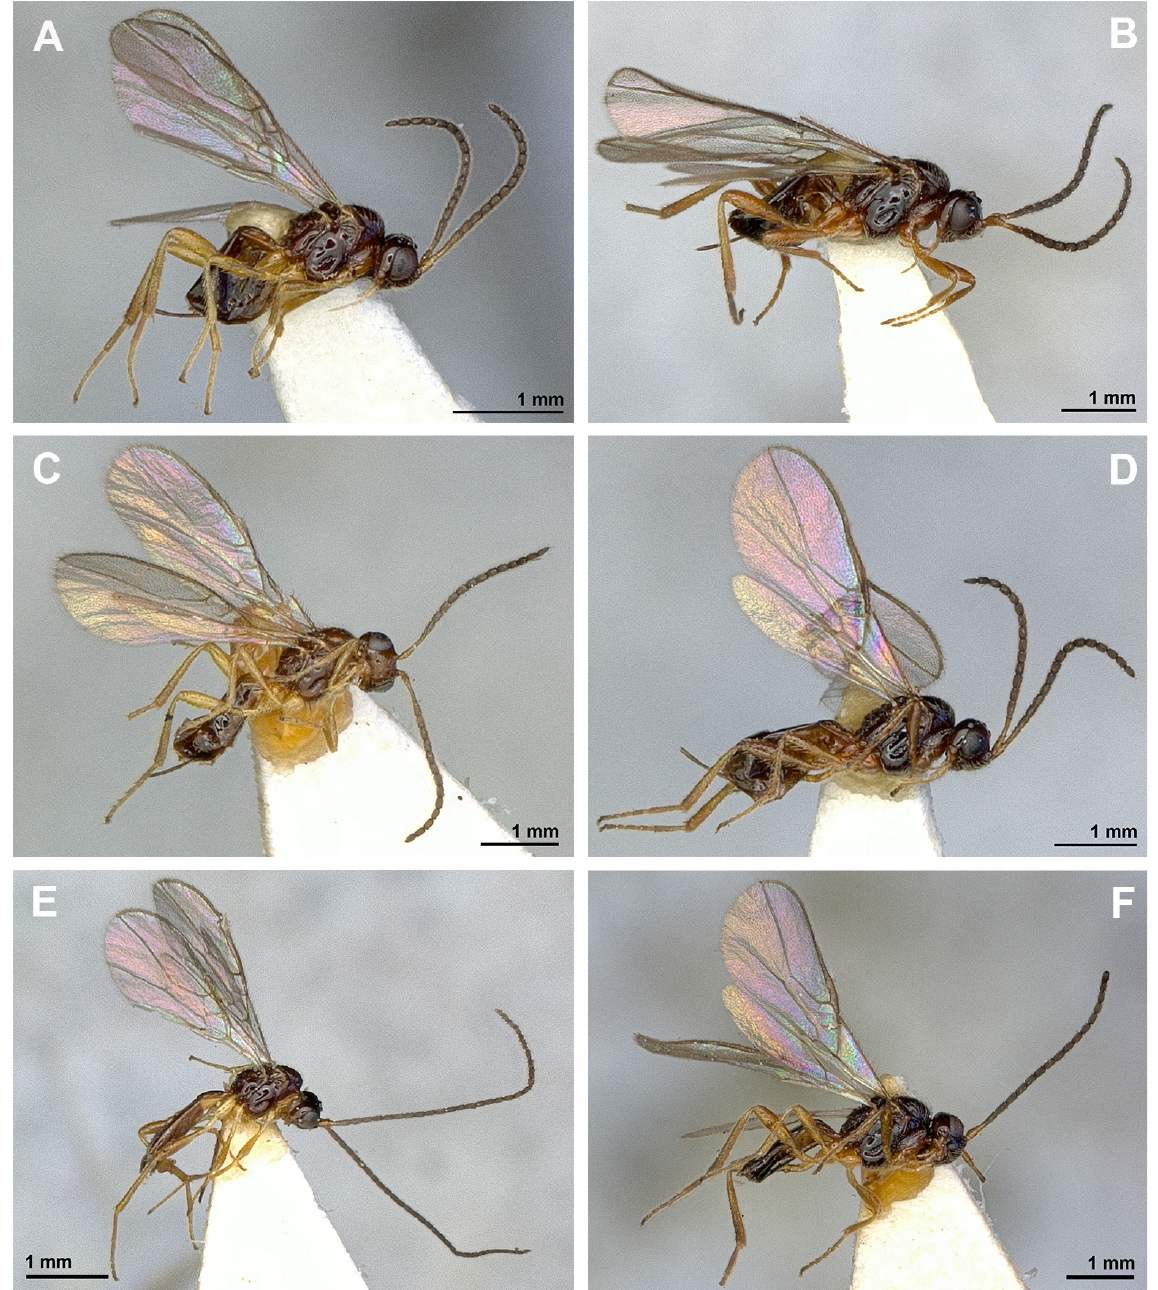
Fig. 5. Dinotrema subbidentatum Peris-Felipo sp. nov. (A–D ♀; E–F ♂). A . Habitus variety body light – metasoma short, lateral view. B . Habitus variety body dark – metasoma short, lateral view. C . Habitus variety body light – metasoma long, lateral view. D . Habitus variety body dark – metasoma long, lateral view. E . Habitus variety body light, lateral view. F . Habitus variety body dark, lateral